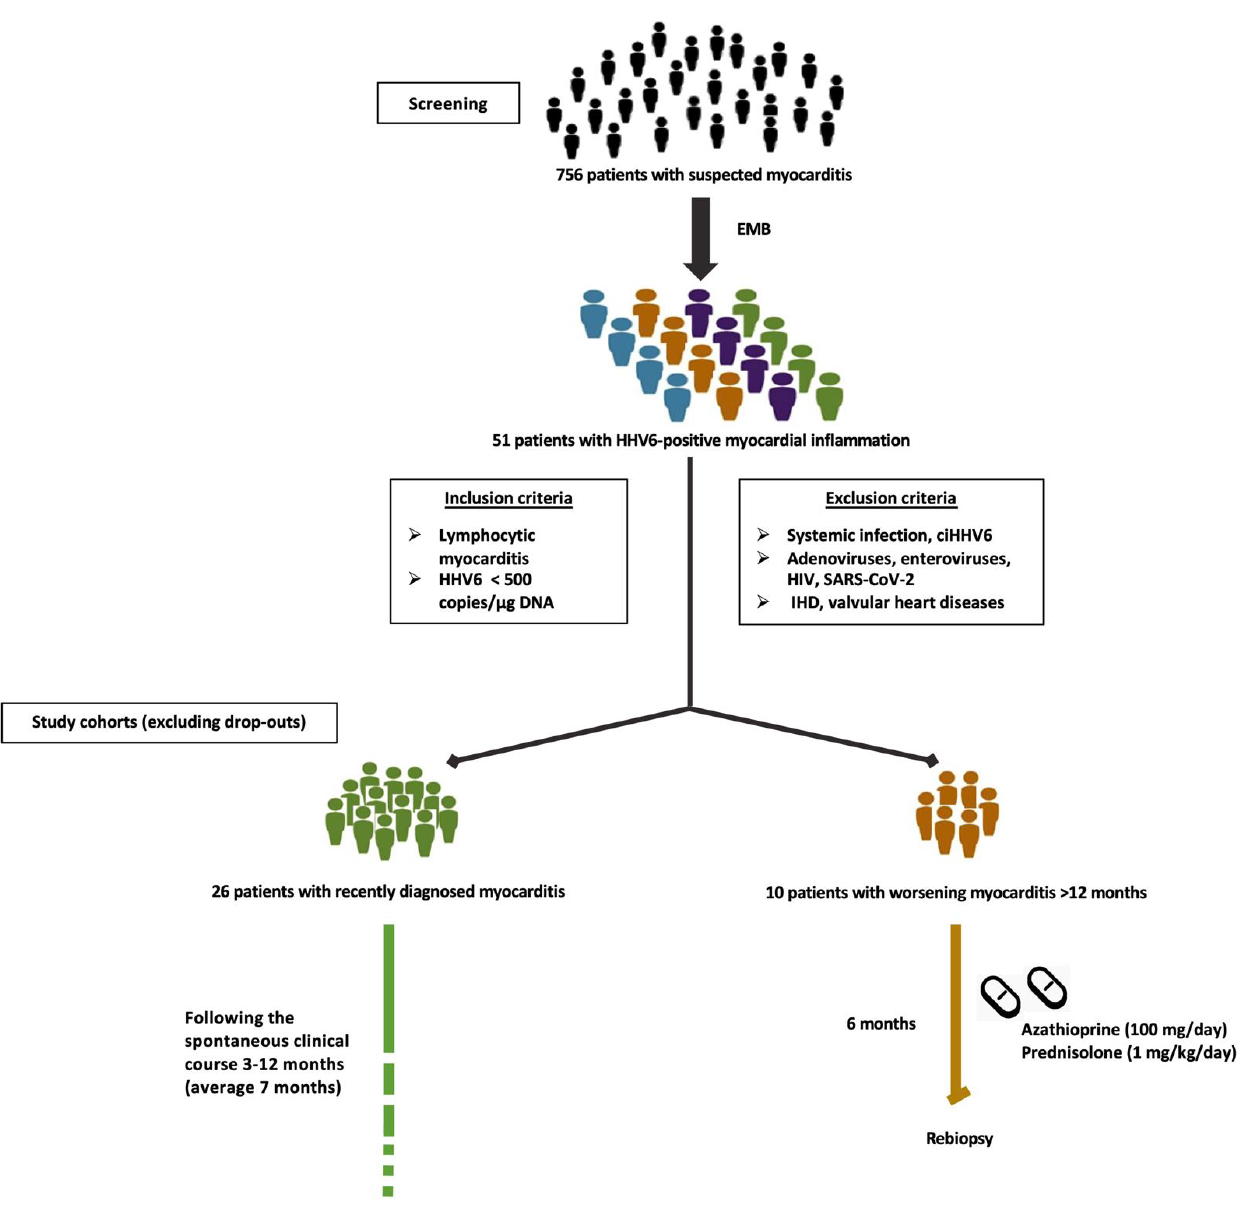
Figure 1. Study design. EMB, endomyocardial biopsy; HHV6, human herpesvirus 6; ciHHV6, chromosomally integrated human herpesvirus 6; HIV, human immunodeficiency virus; SARS-CoV-2, severe acute respiratory syndrome coronavirus 2; IHD, ischemic heart disease. Recent-onset myocarditis patients ( N = 26, left ventricular ejection fraction (LVEF) = 42 ± 13%, age: 48 ± 18 years, 16 males) were closely monitored over a spontaneous course of 3 months up to 1 year, median = 7 months. Two patients had HHV6A and 24 had HHV6B infection. None of these patients had histologically proven acute myocarditis. The severity of HF symptoms was quantified with the New York Heart Associ- ation (NYHA) classification. N-terminal pro-brain natriuretic peptide (NT-proBNP)